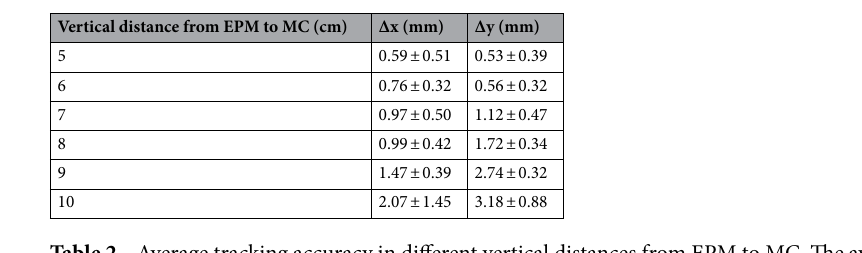
Table 2. Average tracking accuracy in different vertical distances from EPM to MC. The average accuracy presented in mean error ± standard deviation.